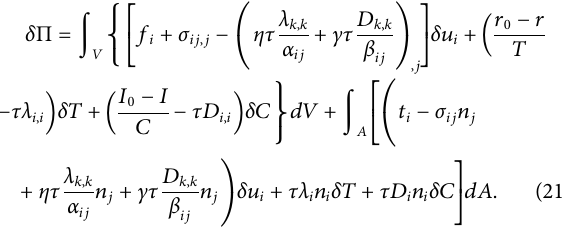
FIGURE 2 Crack-tip pro fi le diagram of crack